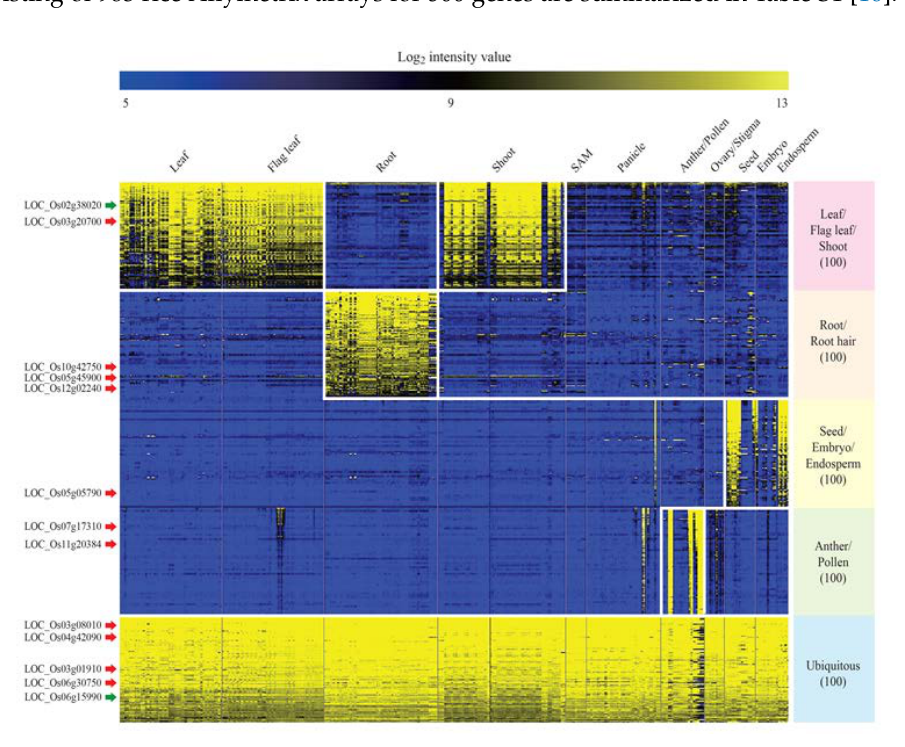
Figure 2. Heat map analysis of organ-specific genes and identification of five clusters.